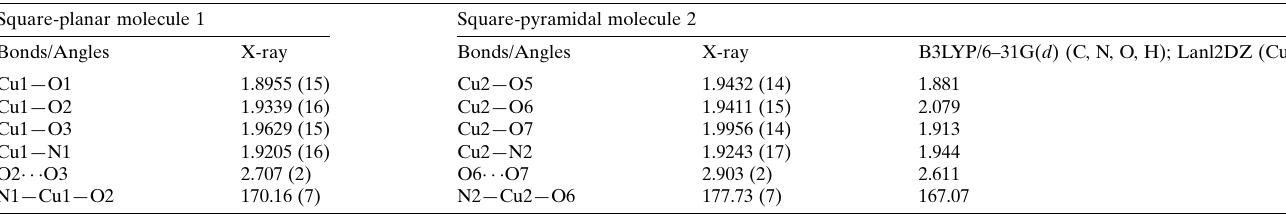
Table 2 Comparison of selected (X-ray and DFT) bond lengths and angles (A˚ , (cid:3) ). Square-planar molecule 1